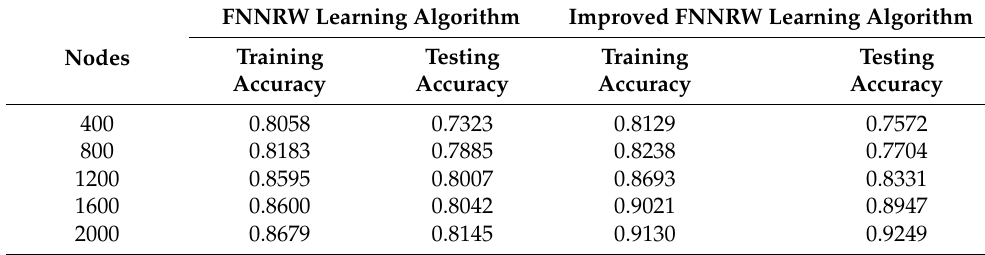
Table 2. Training accuracy and test accuracy of the FNNRW learning algorithm and the optimized FNNRWs learning algorithm when samples are divided into 20 subsets. We partitioned the entire huge dataset into 20 smaller datasets, using the training set and test set to examine how well the improved method performed. The accuracy of each dataset is displayed in the